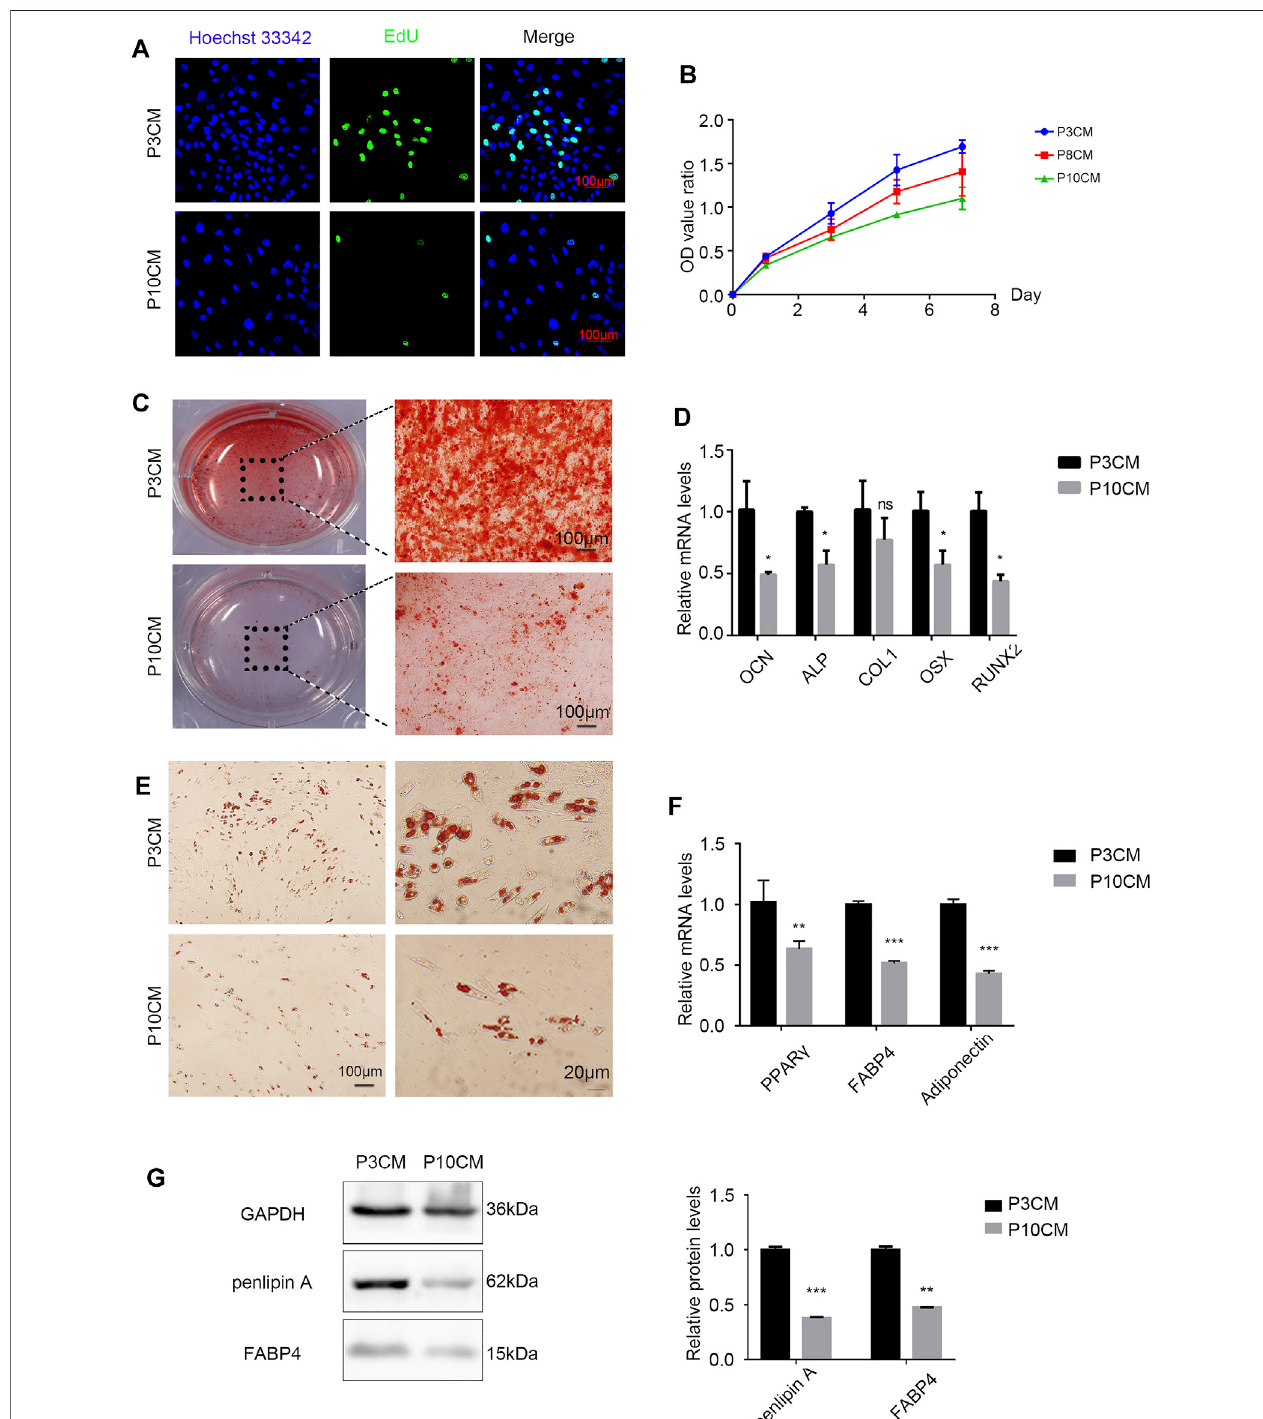
FIGURE 2 | CM from the senescent MSCs changes the physiology of young BMSCs. (A) EdU staining of the BMSCs cultured with P3 CM or P10 CM (scale bar: 100 μ m). (B) Growth curves of the BMSCs cultured with P3 CM or P10 CM. (C) Alizarin red staining shows the osteogenic induction of the young BMSCs cultured with P3CMorP10CM( n =3,magni fi cation:×100,andscale:100 µm). (D) Real-timePCRshowingtheexpressionsofOCN,ALP,COL1,OSX,andRUNX2( n =3,* p < 0.05, ns., and p > 0.05). (E) Oil red Ostainingofthe youngBMSCscultured with P3CM or P10 CM. (F) Real-timePCR showing theexpressionsofPPAR γ , FABP4, and adiponectin ( n = 3, ** p < 0.01, and *** p < 0.001). (G) Western blot analysis of lipid-related indicators such as FABP4 and perilipin A ( n = 3, ** p < 0.01, and *** p < 0.001).